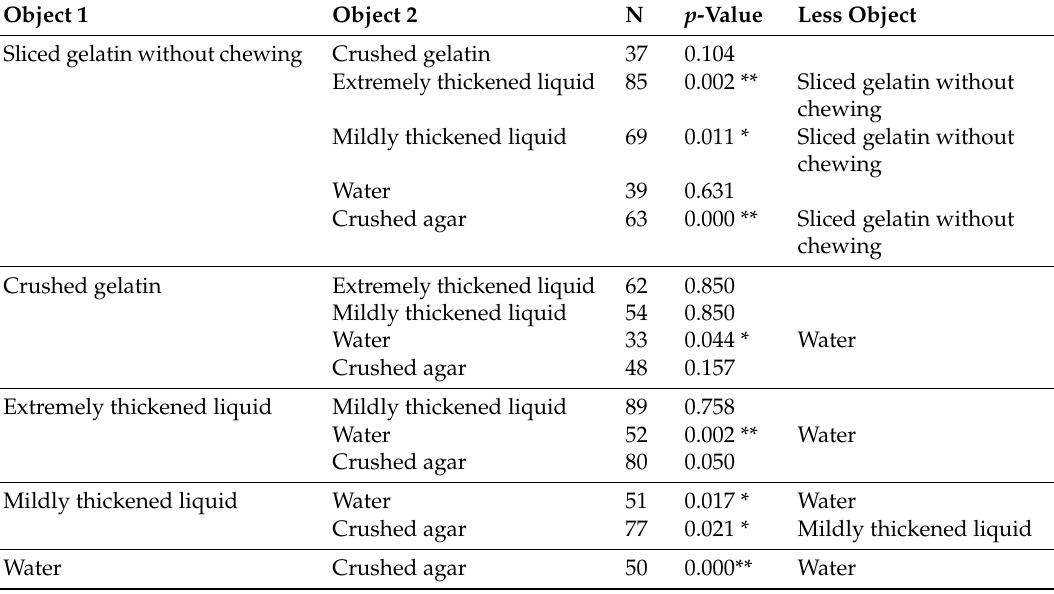
Table 5. Di ff erences in the frequency of pharyngeal residue among food